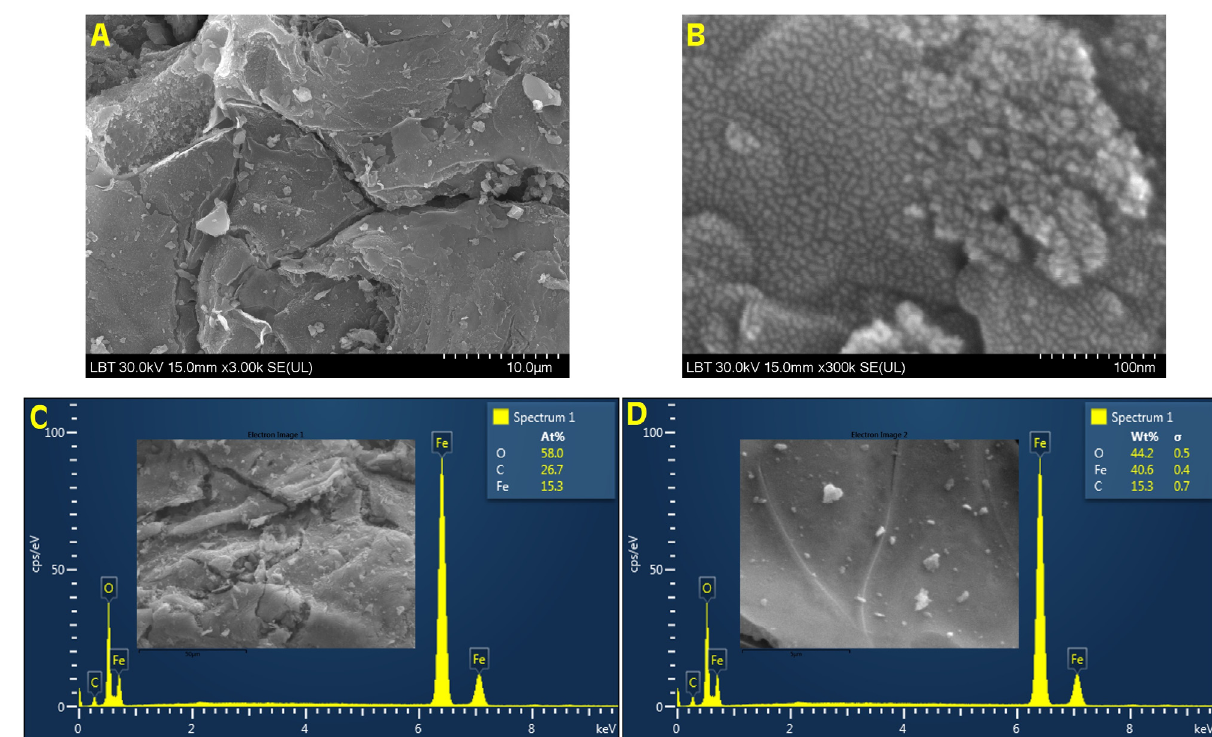
Figure 3. SEM images for Fe 3 O 4 @Carbon nanoparticles synthesized by the combustion method at different orders of magnitude: ( A )—10 µ m; ( B )—100 nm; ( C )—EDX spectrum with the atomic percentage of the elements recorded, and ( D )— EDX spectrum with the weight percentage of the elements recorded.